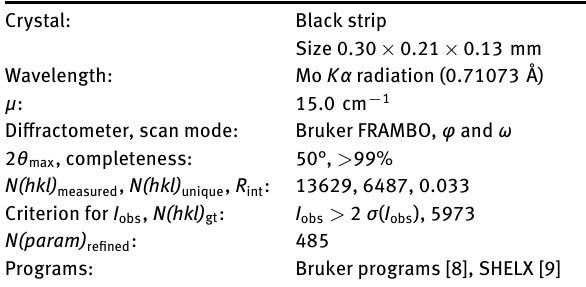
Table 1: Data collection and handling. Table 2: Fractional atomic coordinates and isotropic or equivalent isotropic displacement parameters (Å 2